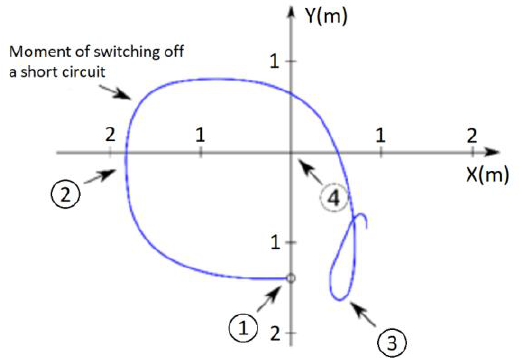
Figure 4. Example of the range of movement of one phase’s conductors during a short circuit [9].